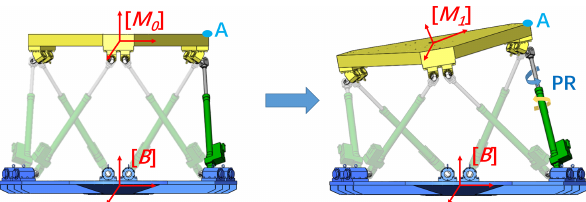
Figure 1. Configuration and Cartesian coordinate systems of a 6- DOF Stewart